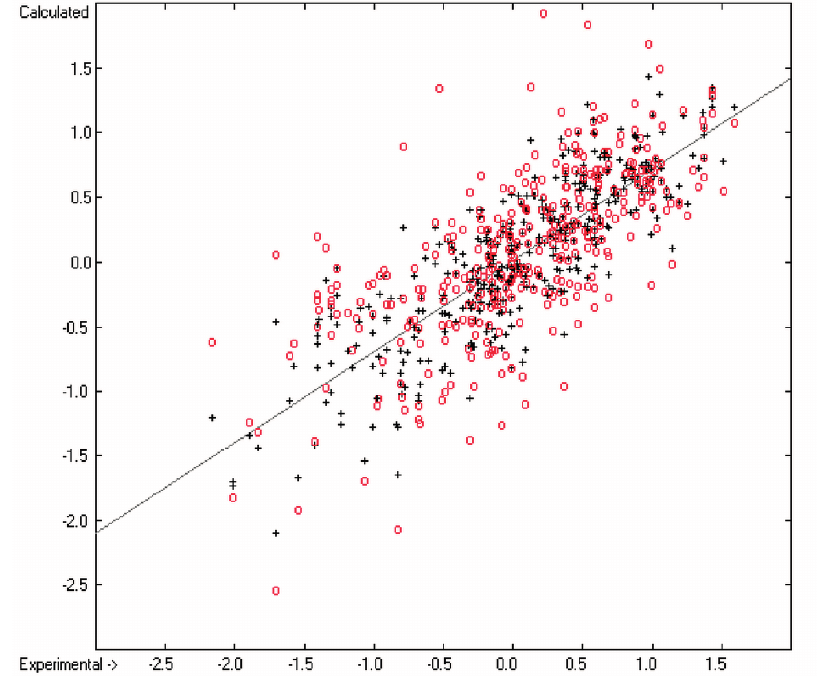
Figure 23. Correlation diagram of logBB data (10-fold cross-validated: N = 385; Q 2 = 0.4786; slope =